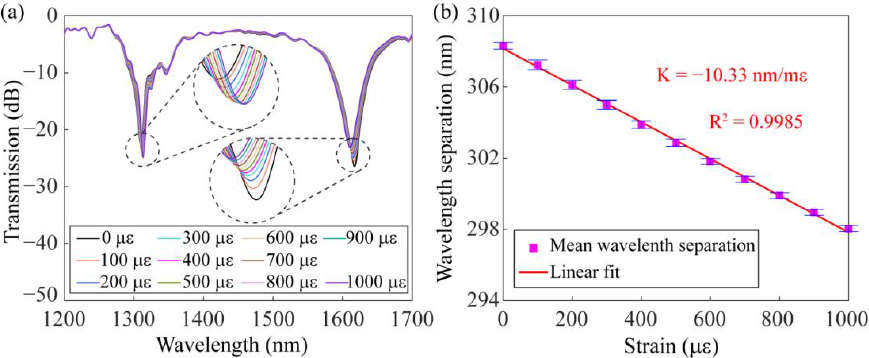
Figure 17. ( a ) Transmission spectra of the dual-resonance SMF-HLPG with different strains. ( b ) The dependence of mean wavelength separation on the strain.